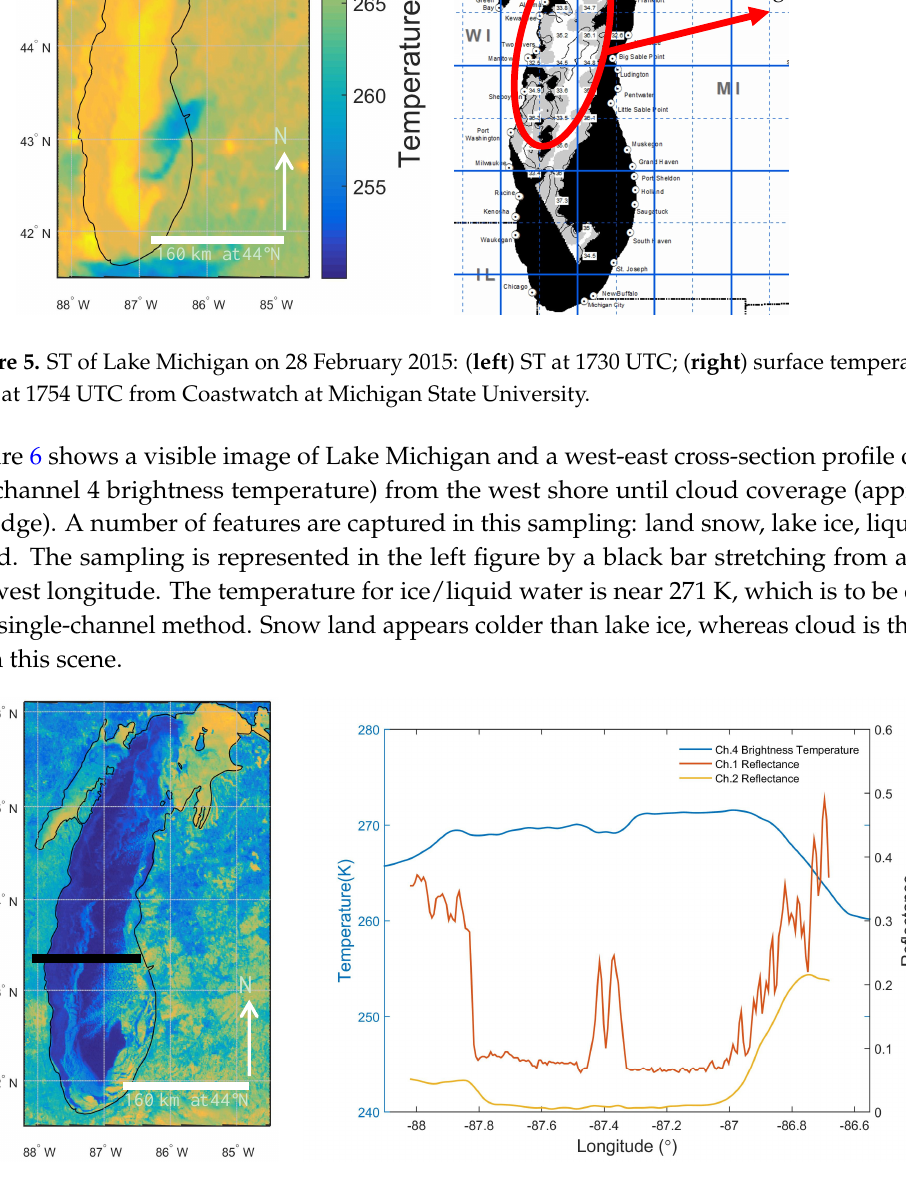
Figure 6. ( Left ) 0.62 µm image of Lake Michigan at 1830 UTC on 28 February 2015; ( right ) the R1, R2, ST profile along the cross section indicated by the black line on the left figure. Water/gray ice appears along a stretch from about 88° to 87.5°, with thick ice and/or snow cover centered near about 87.4°, and again water/gray ice from 87.3° to 87°. The spectral properties of liquid water, gray ice, and “thick” ice are similar in 3.9 µm. The reflectance in the 3.9 µm is near 0.05. In the 0.62 µm channel, the reflectance of gray ice and water is just under 0.1, whereas thick ice/snow